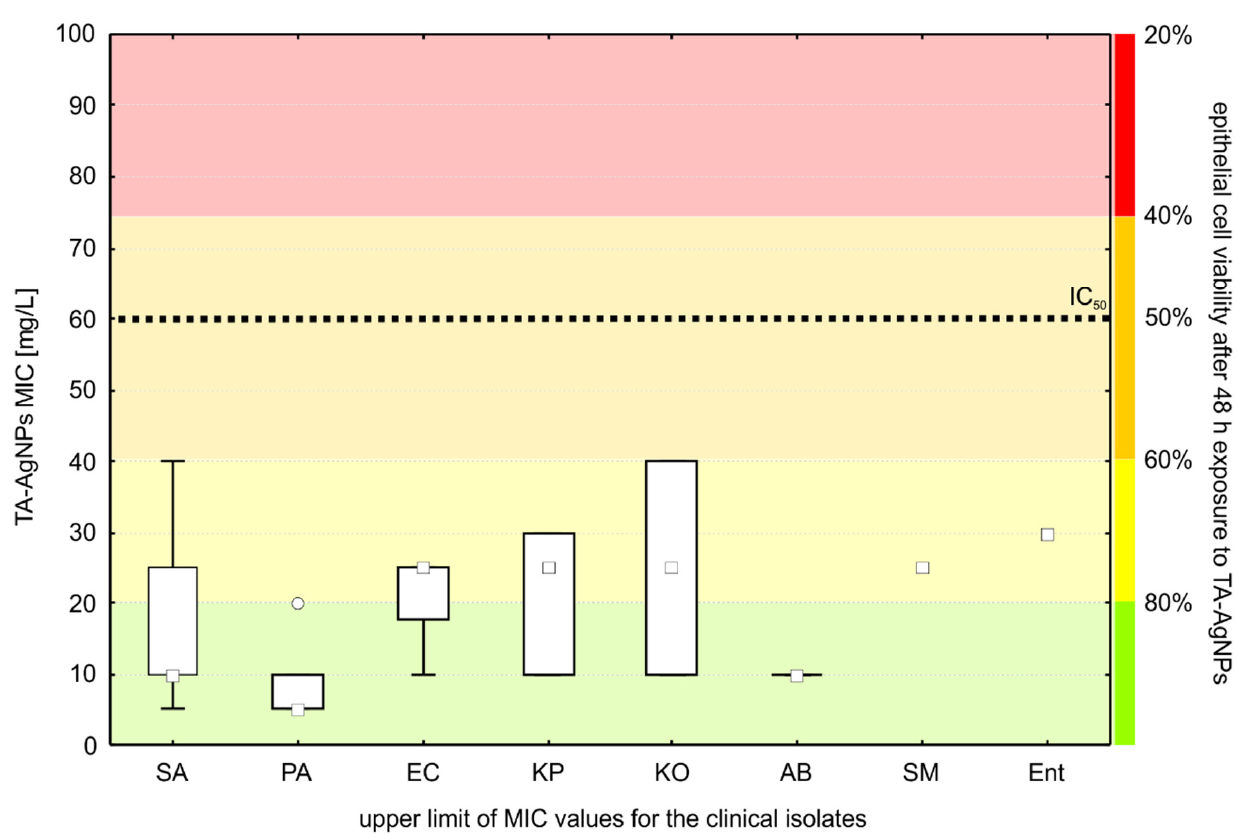
Figure 6. MIC upper limits for the clinical isolates compared to the nasal epithelial cell viability after 48 h exposure to TA-AgNPs (IC 50 —the half-maximal inhibitory concentration). SA— Staphylococcus aureus , PA— Pseudomonas aeruginosa , EC— Escherichia coli , KP— Klebsiella pneumoniae , KO— Klebsiella oxytoca , AB— Acinetobacter baumannii , SM— Serratia marcescens , Ent— Enterobacter cloacae). The boxes represent the interquartile range; the whiskers extend to the highest and lowest values, the squares represent the median values, and the circle represents an